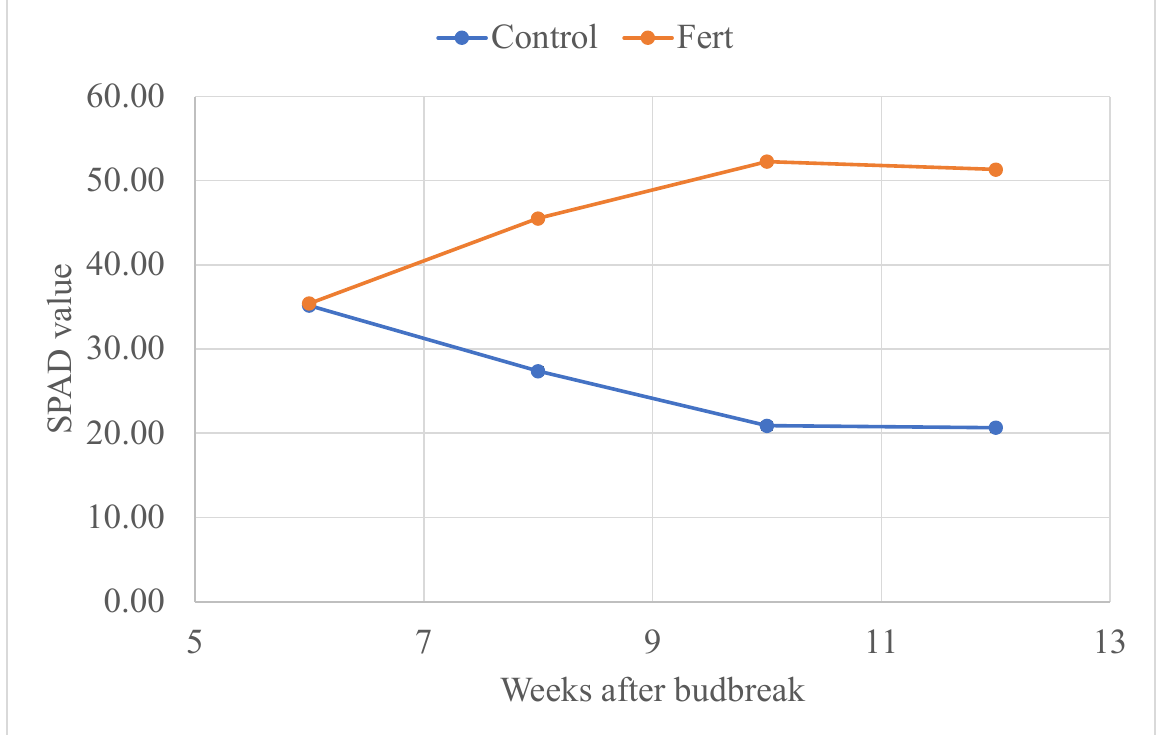
Figure 3. Mean values ( ± standard error) of SPAD readings over time for fertilized treatment (Fert) and water